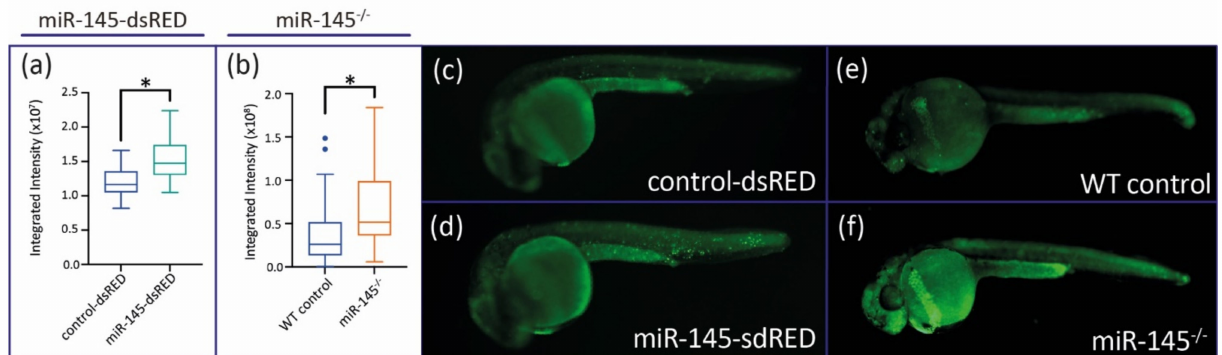
Figure 6. Apoptosis levels are analyzed in miR-145 gain- and loss-of-function embryos. ( a ) Quantification of Acridine Orange fluorescence of control-dsRED and miR-145-dsRED microinjected embryos at 24 hpf. ( b ) Quantification of Acridine Orange fluorescence of WT control and miR-145 − / − mutant embryos at 24 hpf. Student’s t -test, * p < 0.0001. ( c – f ) Pictures of control-dsRED ( c ), miR-145 overexpressing ( d ), WT ( e ), and miR-145 − / − ( f ) 24 hpf embryos stained with Acridine